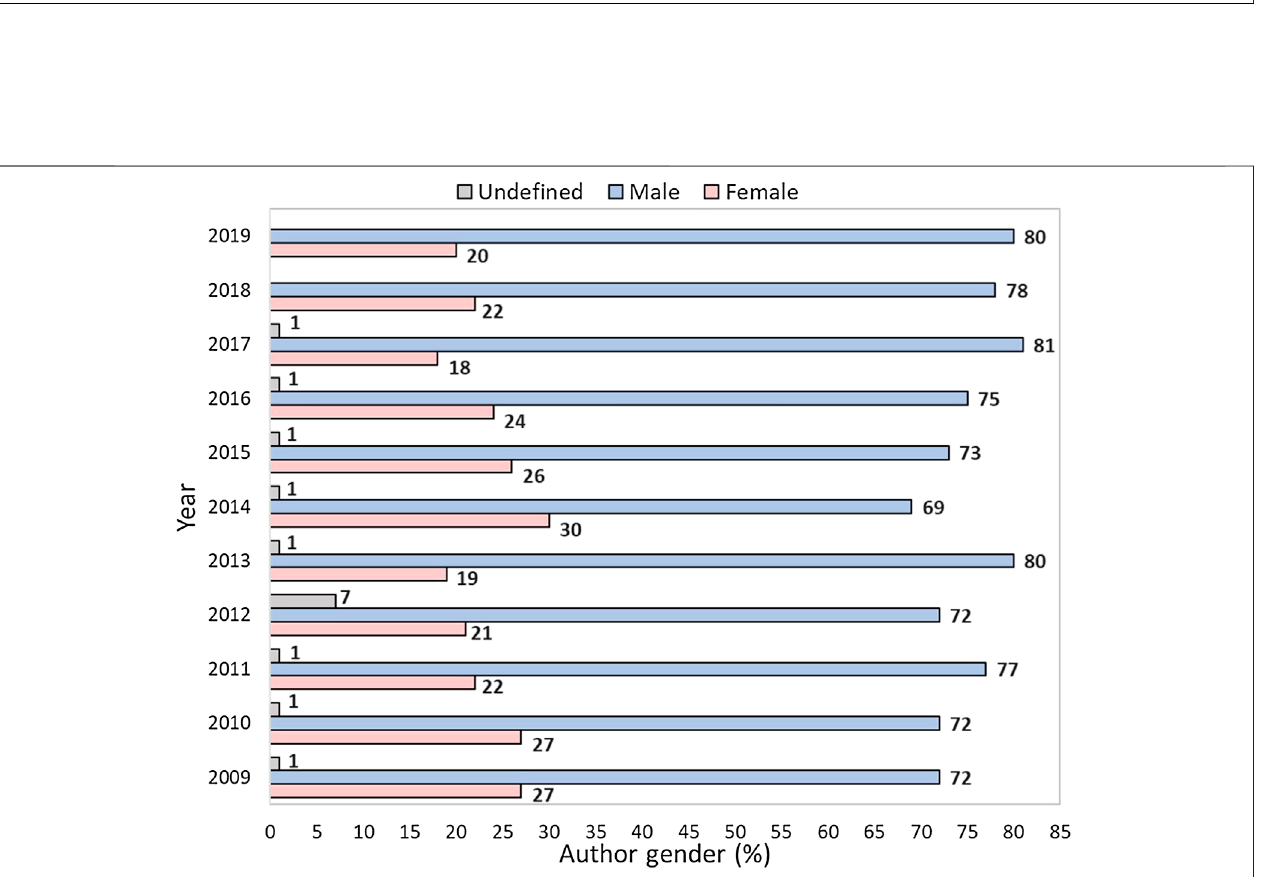
Frontiers in Materials |